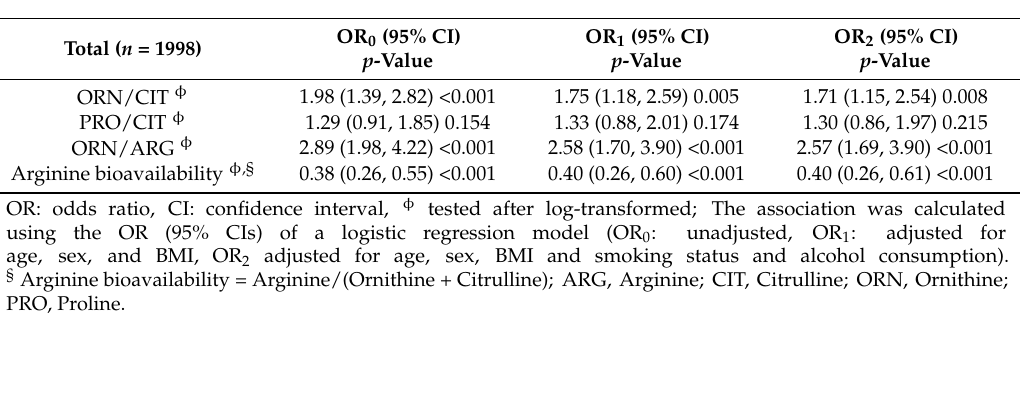
Table 3. Risk of MetS associated with circulating amino acid